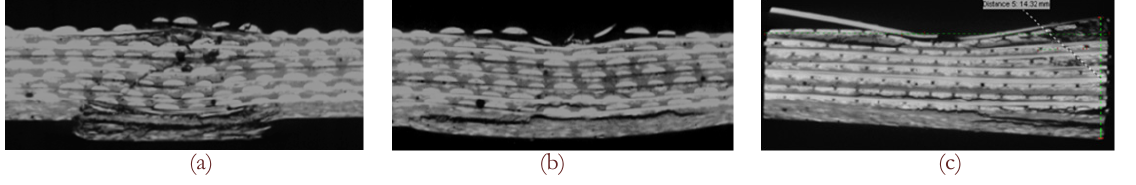
Figure 11: Tomograms of a GFRP laminated panel after the impact (v = 6 m/s).